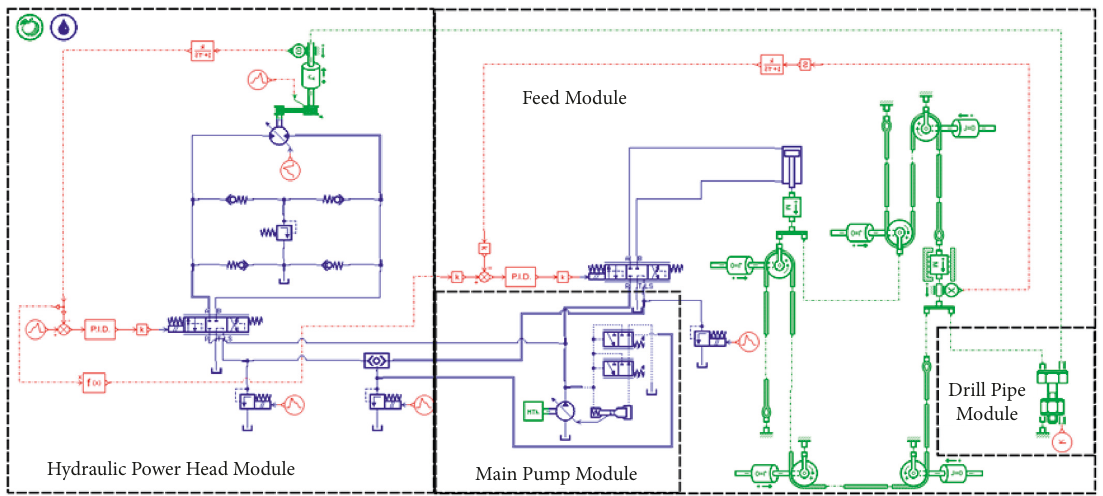
Figure 5: Simulation model of loading and unloading drill pipe. Table 1: Simulation boundary parameters of the hydraulic system of the geological drilling rig.